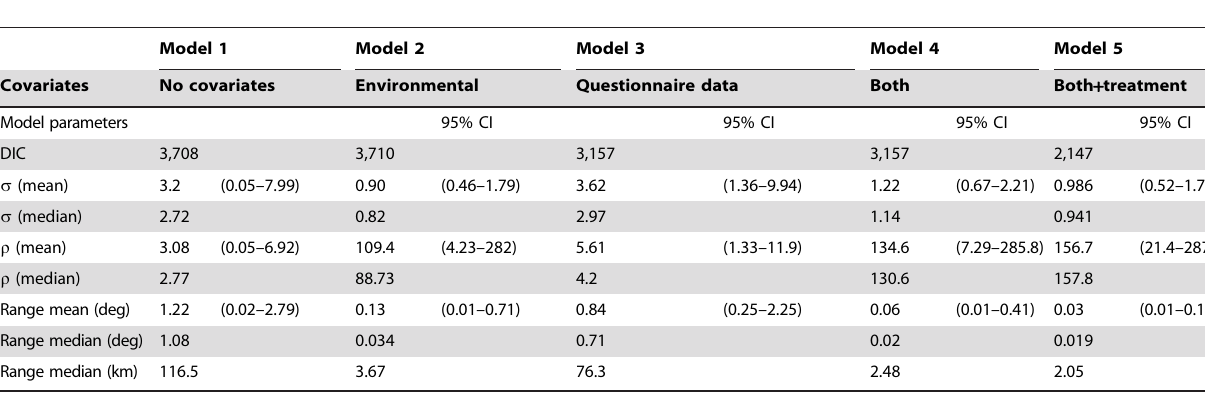
Table 2. Model parameters of the five spatially explicit